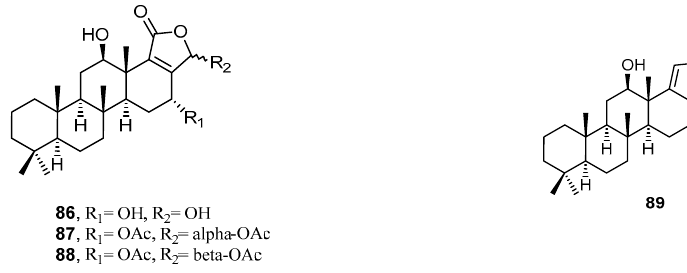
Figure 21. Chemical structures of similan A ( 80 ) and compounds 81 – 89 .